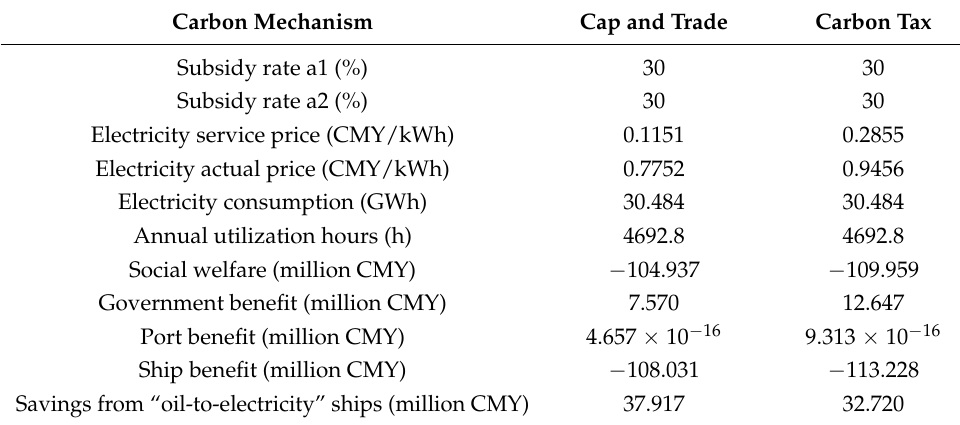
Table 2. Comparison of the impact of subsidy rates on economic benefits to all parties under the two carbon regimes.